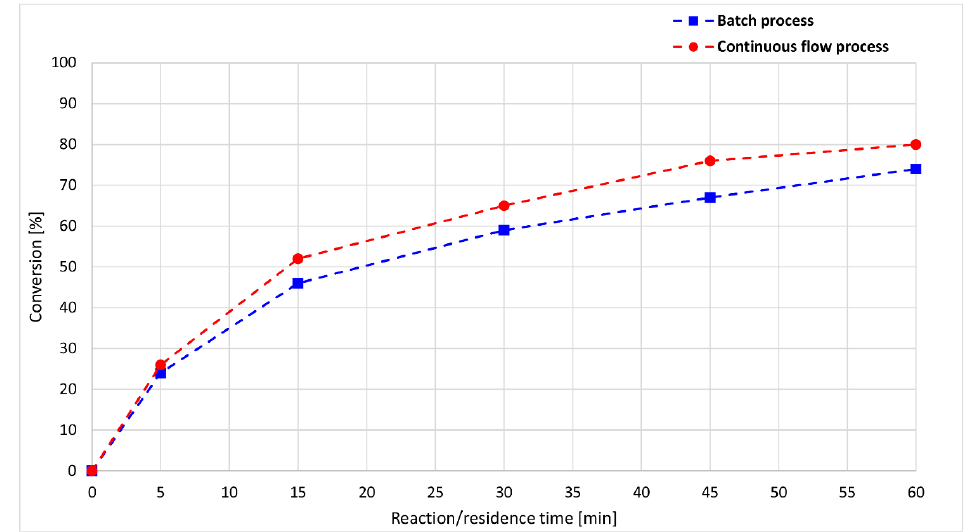
Figure 4. Reaction/residence time-dependence of the conversion of the alcoholysis of DMP with n BuOH at 100 °C.